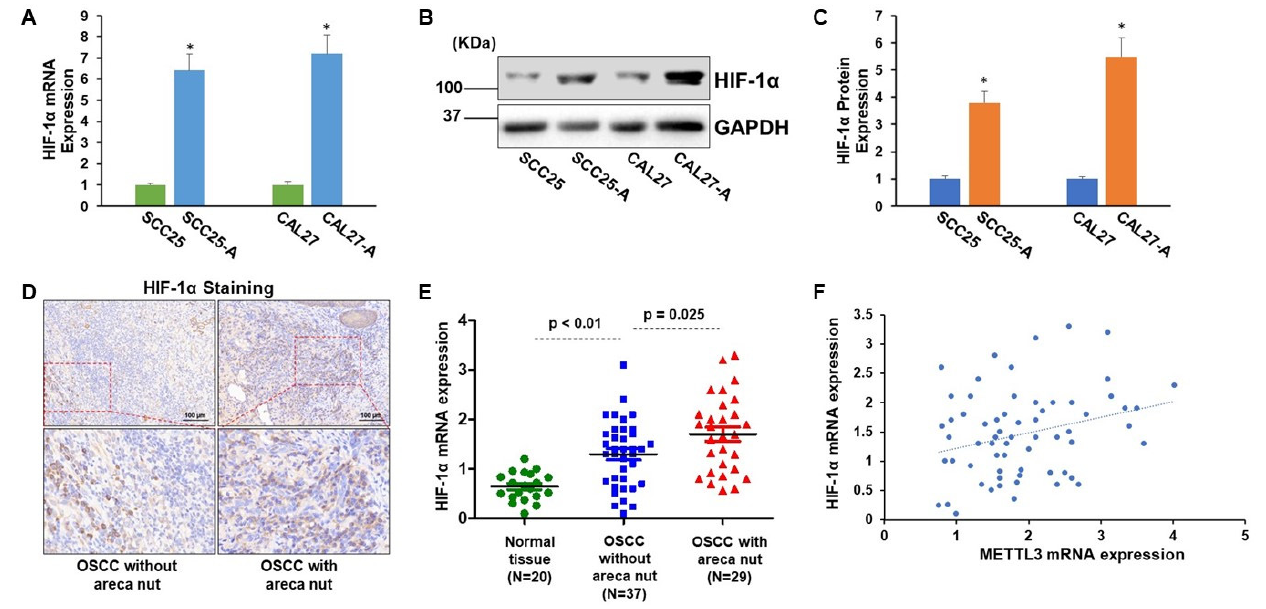
Figure 3. HIF-1 α is markedly enhanced in arecoline-transformed OSCC cell lines and tissues. ( A ) The HIF-1 α mRNA levels in CAL27, SCC25, CAL27-A, and SCC25-A were tested. ( B , C ) The HIF-1 α protein levels in CAL27, SCC25, CAL27-A, and SCC25-A cells were measured ( B ) and quantified by Image J ( C ). ( D , E ) The HIF-1 α levels in normal oral tissues ( n = 20), OSCC without areca nut ( n = 37), and OSCC with areca nut ( n = 29) were identified using IHC staining ( D ) and RT-qPCR assay ( E ). * p < 0.05 compared to the control group. ( F ) Pearson correlation method was utilized to assess the association between HIF-1 α and METTL3 in OSCC tissues. * p < 0.05 compared to the control group or as indicated.